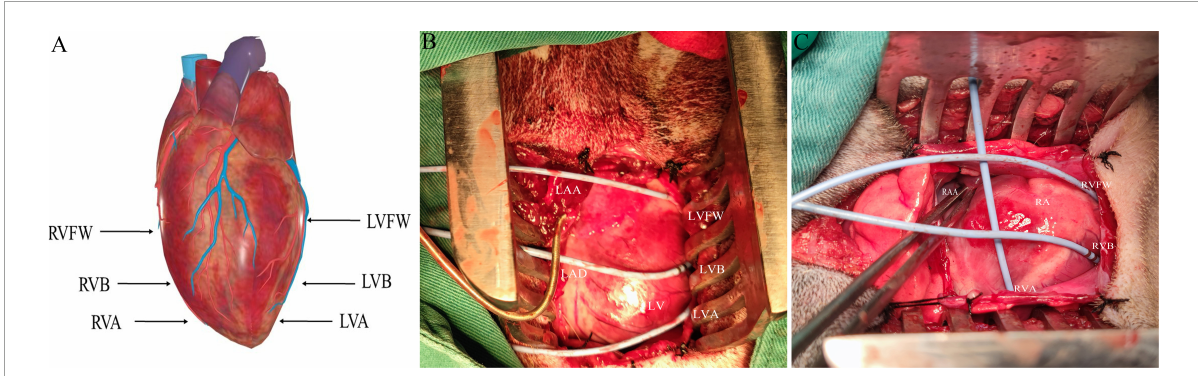
FIGURE3 The schematic diagram of electrode placement position during electrophysiological testing (A) . (B,C) Are electrodes placed in the left ventricle and right ventricle, respectively. LVFW, left ventricular free wall; LVB, left ventricular base; LVA, left ventricular apex; LAA, left atrial appendage; RVFW, right ventricular free wall; RVB, right ventricular base; RVA, right ventricular apex; RAA, right atrial appendage.